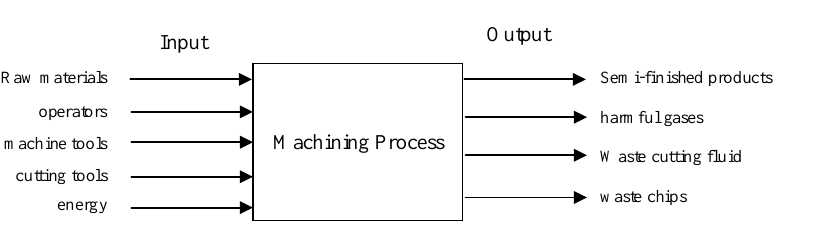
Figure 1. Mechanical processing input and output model.